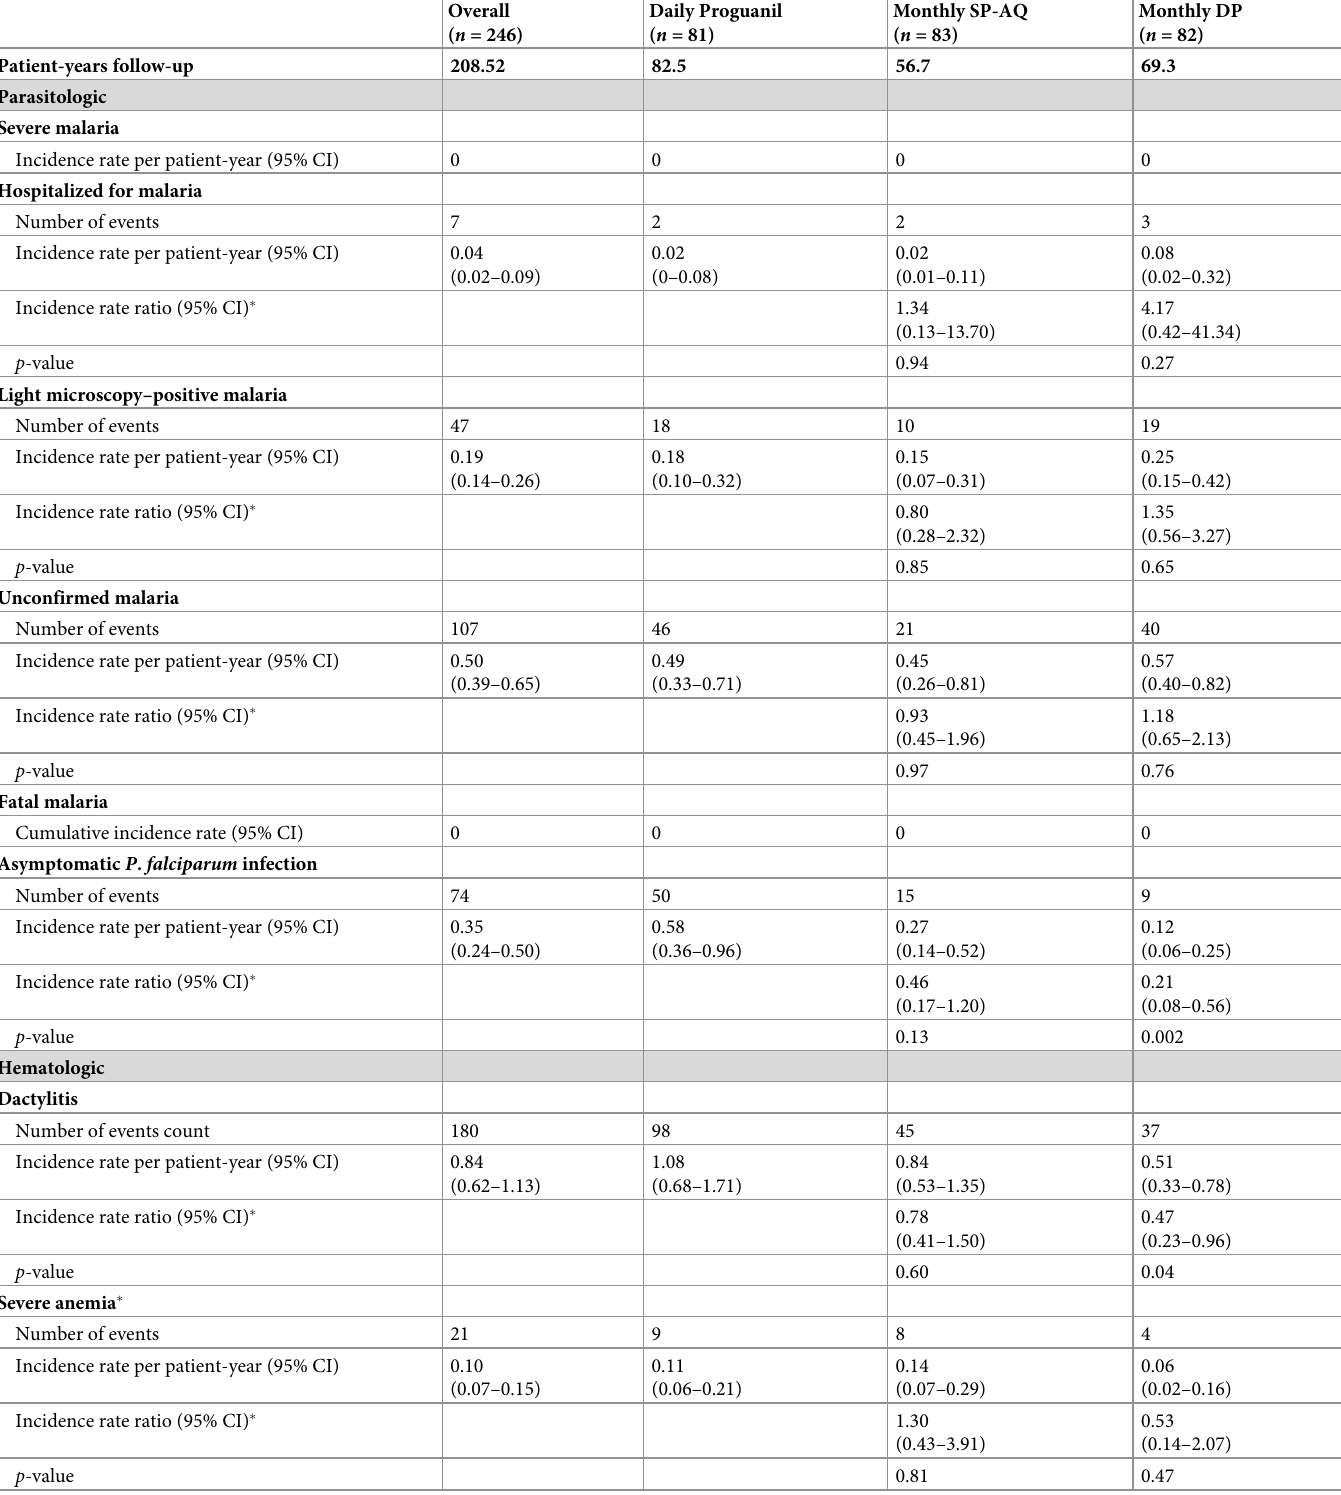
Table 3. Secondary outcomes in the AT